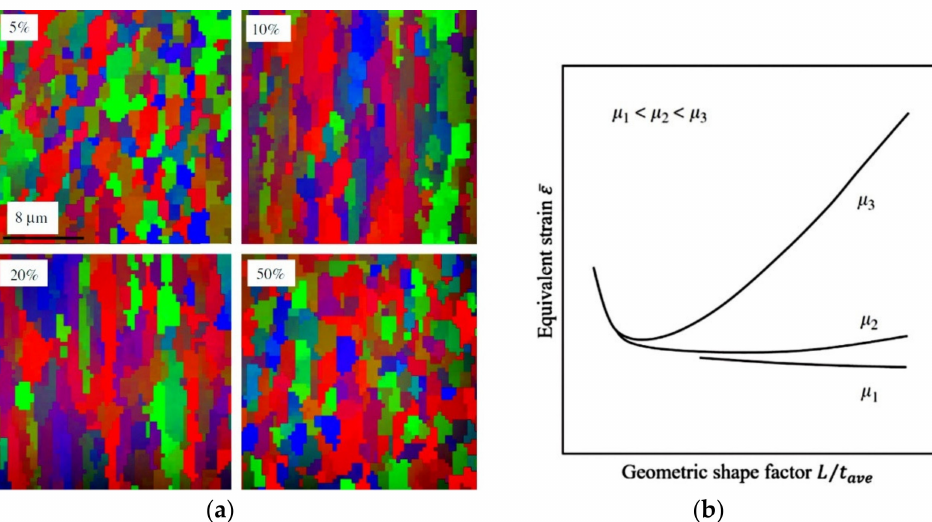
Figure 33. ( a ) EBSD mapping along rolling plane of AA1050 sheets asymmetrically rolled by 93% after annealing at 195 ◦ C for 60 min (thickness reduction from 4.2 mm to 0.3 mm, speed ratio S R ≈ 2.0 due to different diameters of work rolls of 248 mm and 128 mm). ( b ) Schematic representation of equivalent strain ε in the surface layer against geometric shape factor L / t ave at different friction coefficients µ , reproduced from [79], with permission from Elsevier,